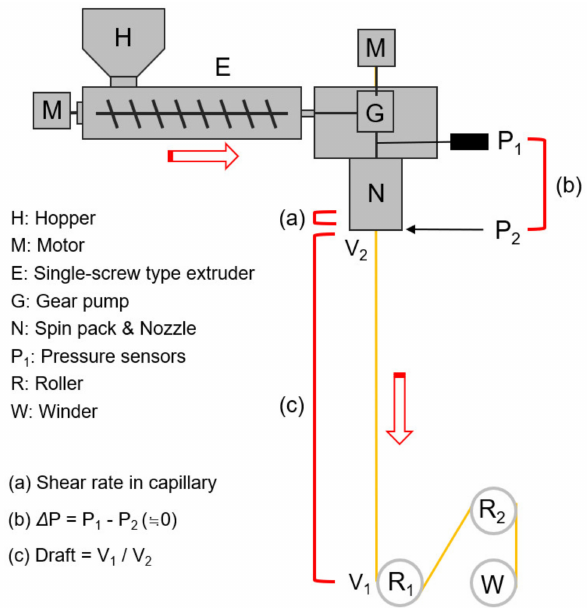
Figure 1. Schematic diagram of high-speed melt spinning process for thermotropic liquid crystalline polymer (TLCP)